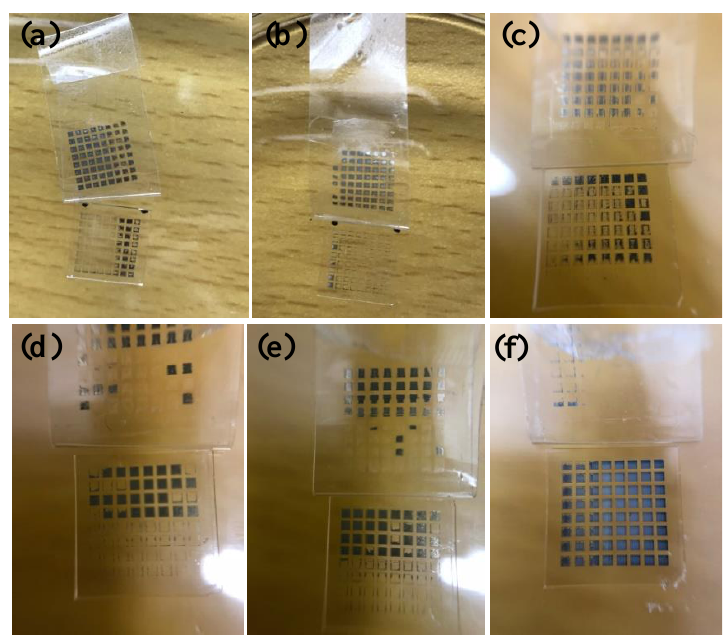
Figure 8. Photos of silver films based on MOD ink after the tape test: ( a ) UV cured at D = 37 cm for 480 s; ( b ) UV cured at D = 29 cm for 480 s; ( c ) UV cured at D = 23 cm for 480 s; ( d ) heat cured at 160 °C for 10 min; ( e ) heat cured at 180 °C for 10 min; ( f ) heat cured at 200 °C for 10 min.